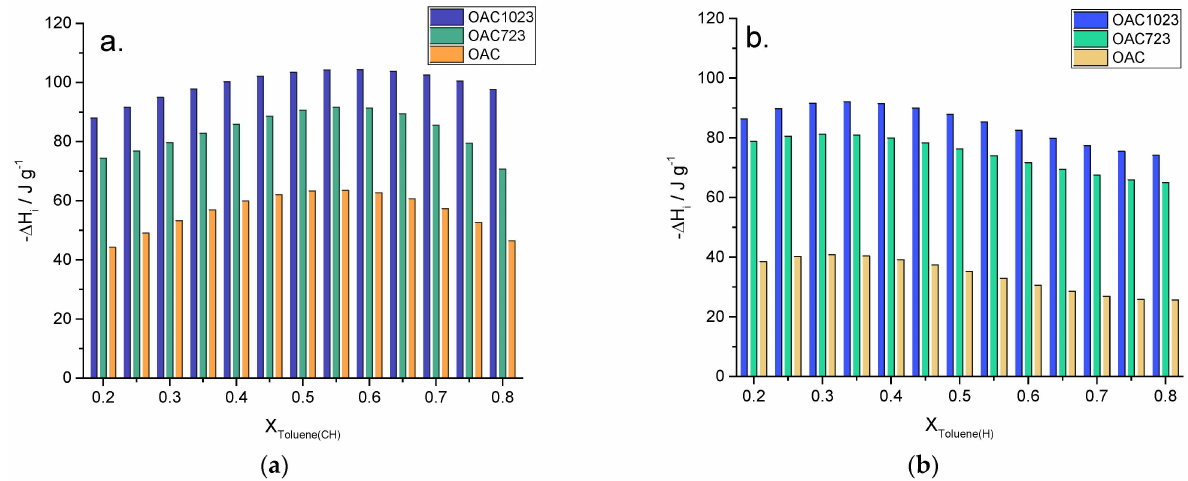
Figure 6. Immersion enthalpies of samples into toluene–cyclohexane ( a ) and toluene–hexane ( b )